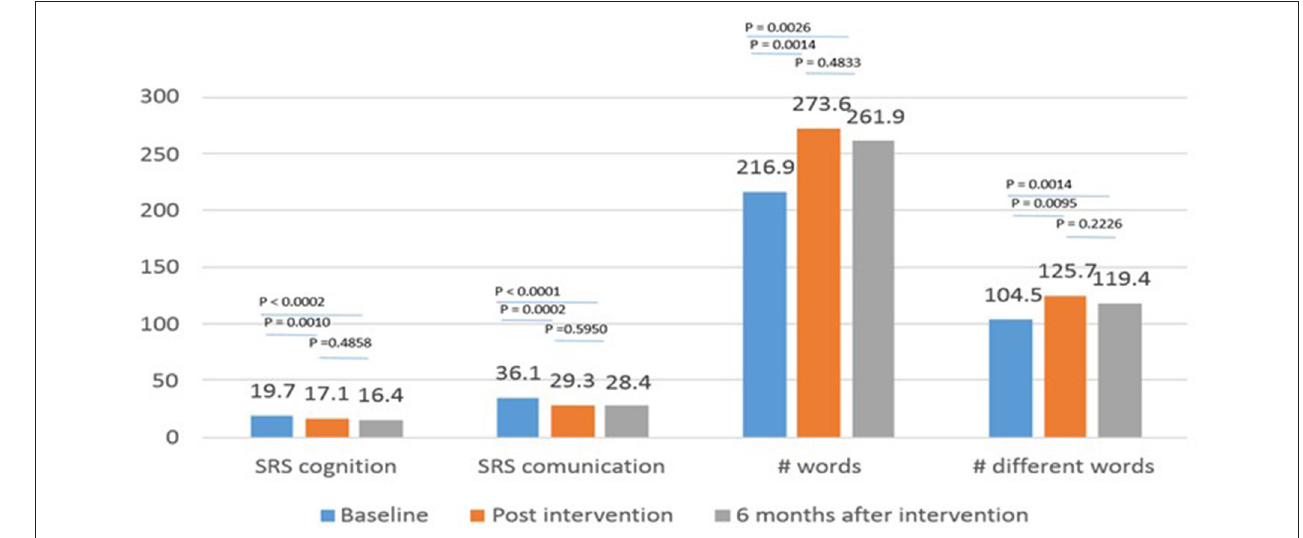
FIGURE 2 | Mean scores at baseline, post-intervention and 6 months after